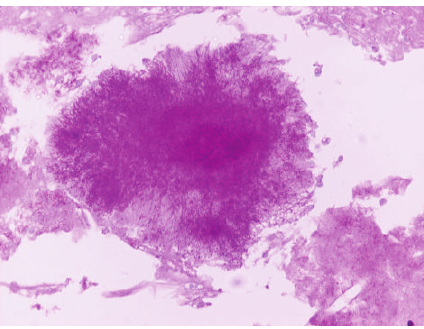
Figure 2: Actinomyces colony PAS ×